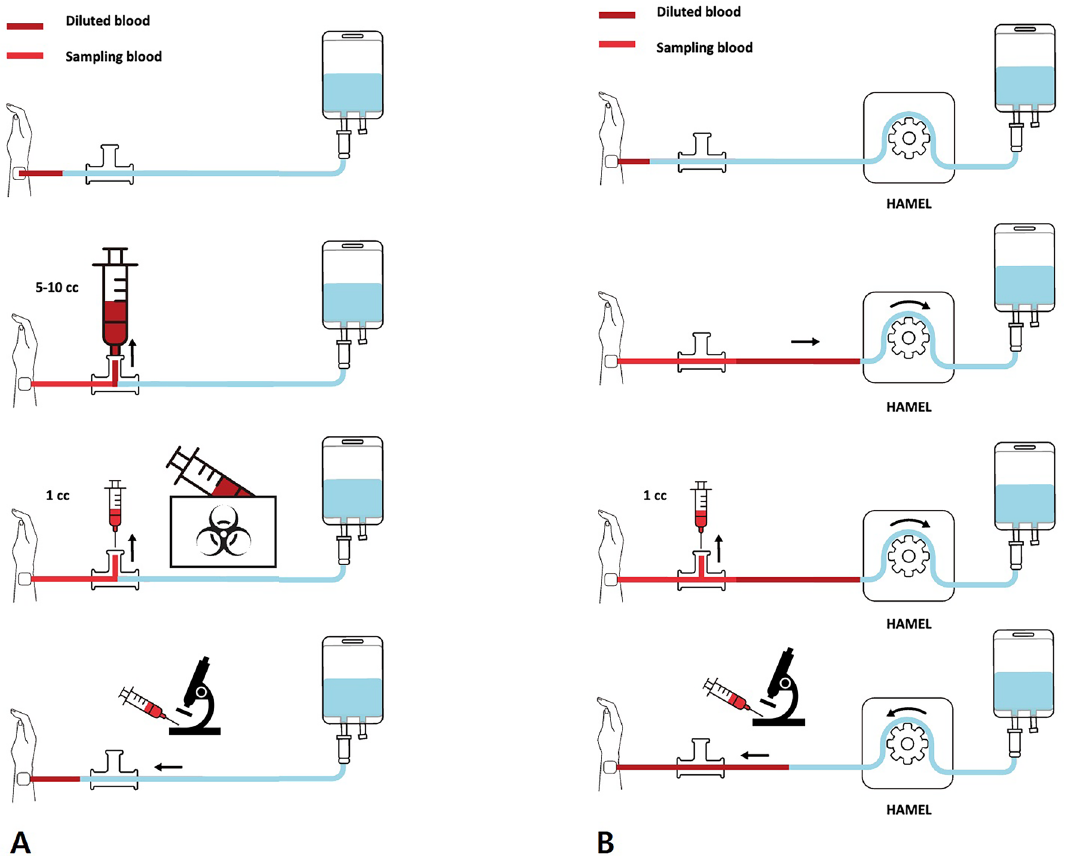
Figure 1. Comparison of HAMEL mechanism to traditional blood sampling method. HAMEL is automated for clearing out and flushing in of normal saline-mixed blood. Since entire process is performed inside closed system of fluid line, there is no unnecessary blood